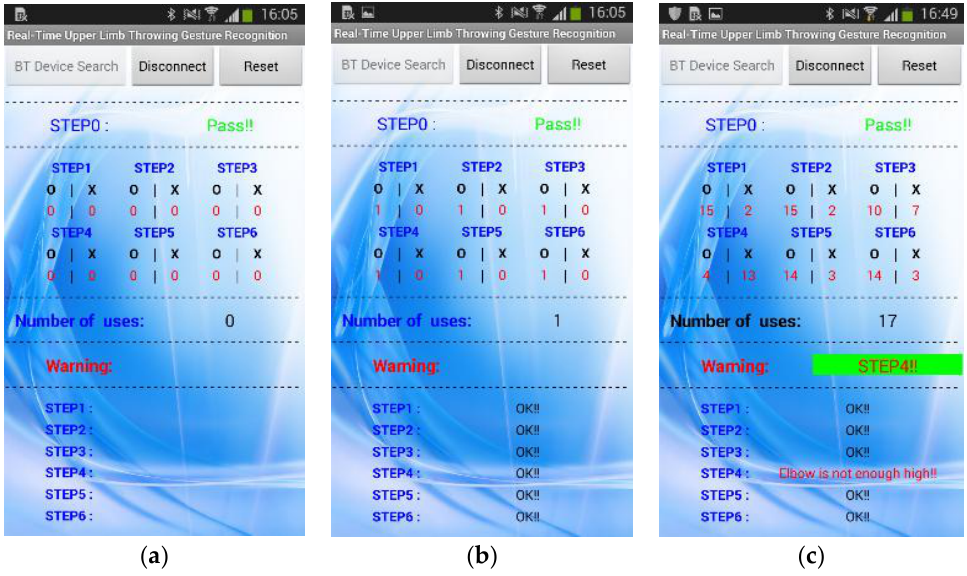
Figure 16. Continuous action signal in multiple throws using the left hand .